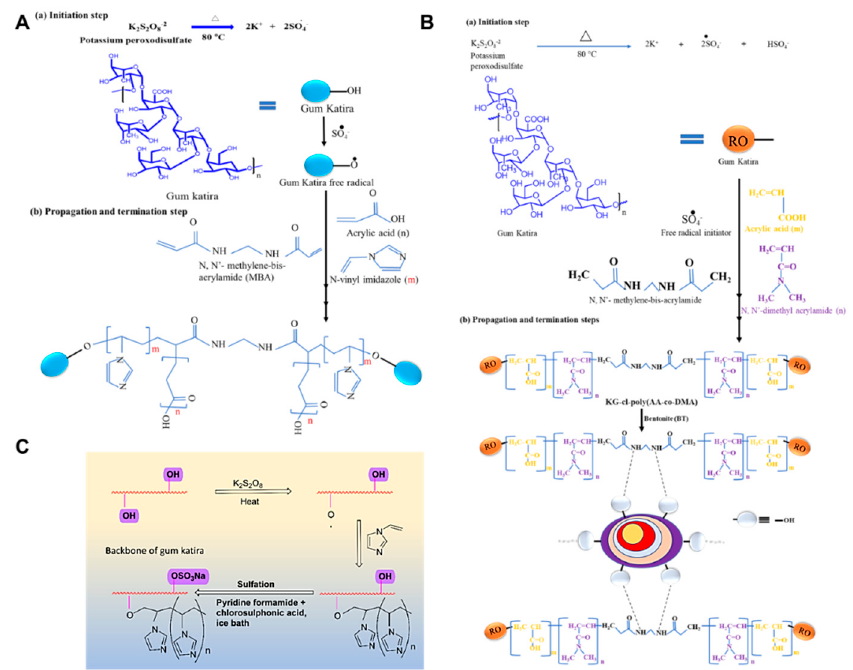
Figure 5. Proposed mechanism for the synthesis of ( A ) gum katira − cl-poly(acrylic acid − co − N − vinyl imidazole) [13] and ( B ) for the synthesis of KG − cl − poly(AA − co − DMA)@BT [116]. ( C )